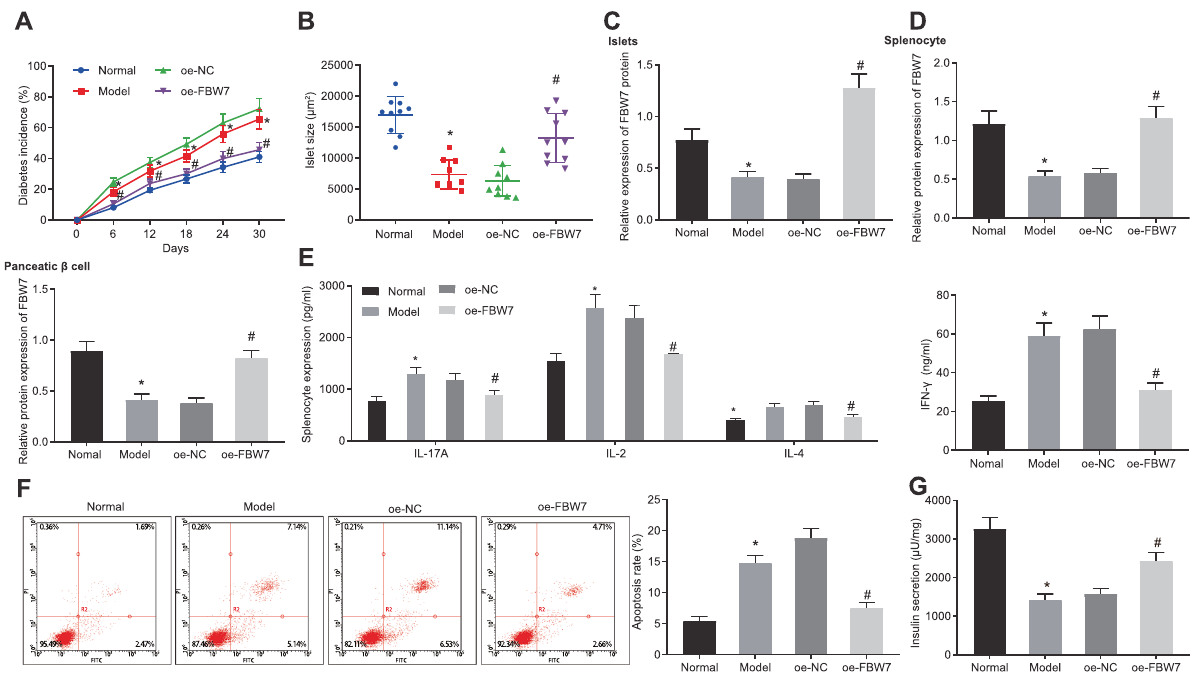
Fig. 2 FBW7 decreases the occurrence of T1D in vivo and in vitro. A The diabetes incidence of each group. B The islet size of each group. C FBW7 expression in mice islet of each group determined by Western blot analysis. D FBW7 expression in induced splenocytes and pancreatic beta cells of each group was determined by Western blot analysis. E The levels of IL-17A, IL-2, IFN- γ , and IL-4 in cell supernatant of each group were determined by ELISA. F The pancreatic beta-cell apoptosis of each group was determined by fl ow cytometry. G The insulin secretion of each group. * p < 0.05, vs. the normal group, # p < 0.05, vs. the OE-NC group. All experiments were conducted in triplicate. Data comparisons between two groups were analyzed by unpaired t -test. Comparisons among multiple groups were performed by one-way ANOVA. Statistical analysis in relation to time-based measurements within each group was realized using repeated-measures